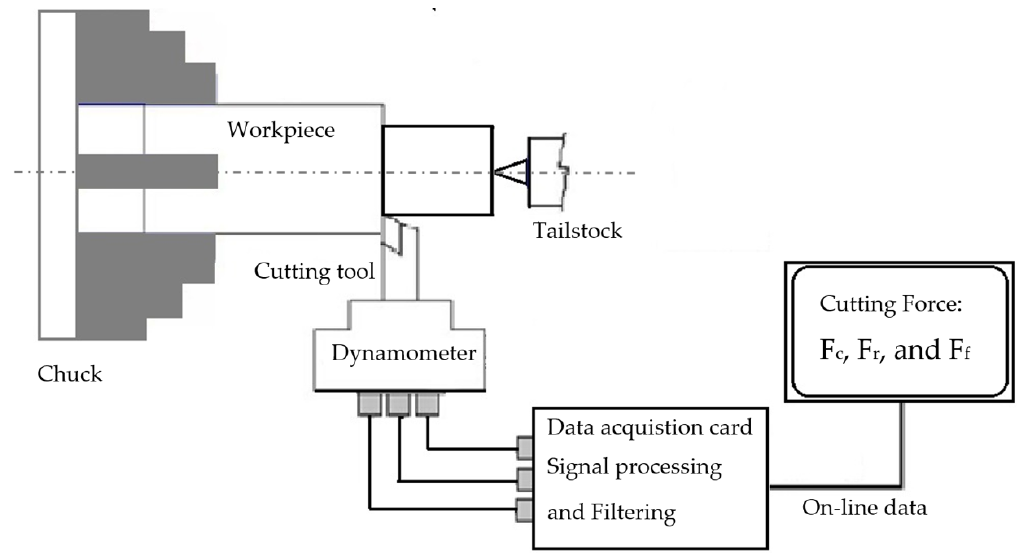
Figure 2. Schematic layout of cutting force measurement setup.